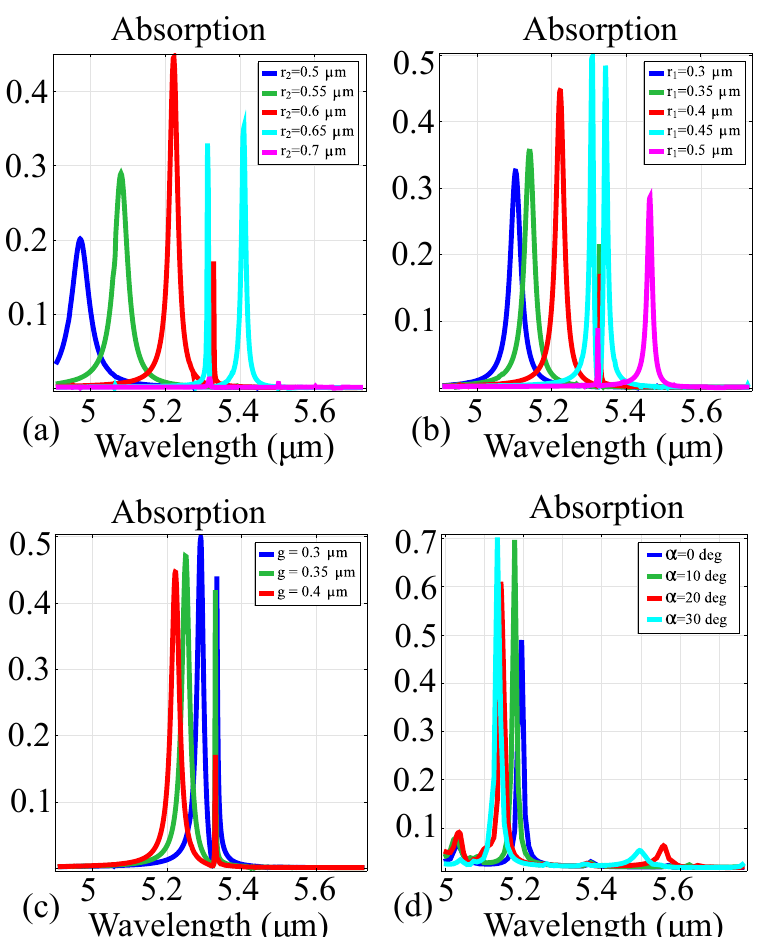
Figure 5. Absorption tuning curves of the hybrid silicon-gold cell as a function of various degrees of freedom: ( a ) tuning curves for a variation of the large cylinder radius r 2 ; ( b ) tuning curves for a variation of the small cylinder radius r 1 ; ( c ) tuning curves for a variation of the substrate thickness g p ; ( d ) tuning curves for a variation of the cylinder inclination axis angle α . For the variation of one parameter, all other ones have their values corresponding to the reference